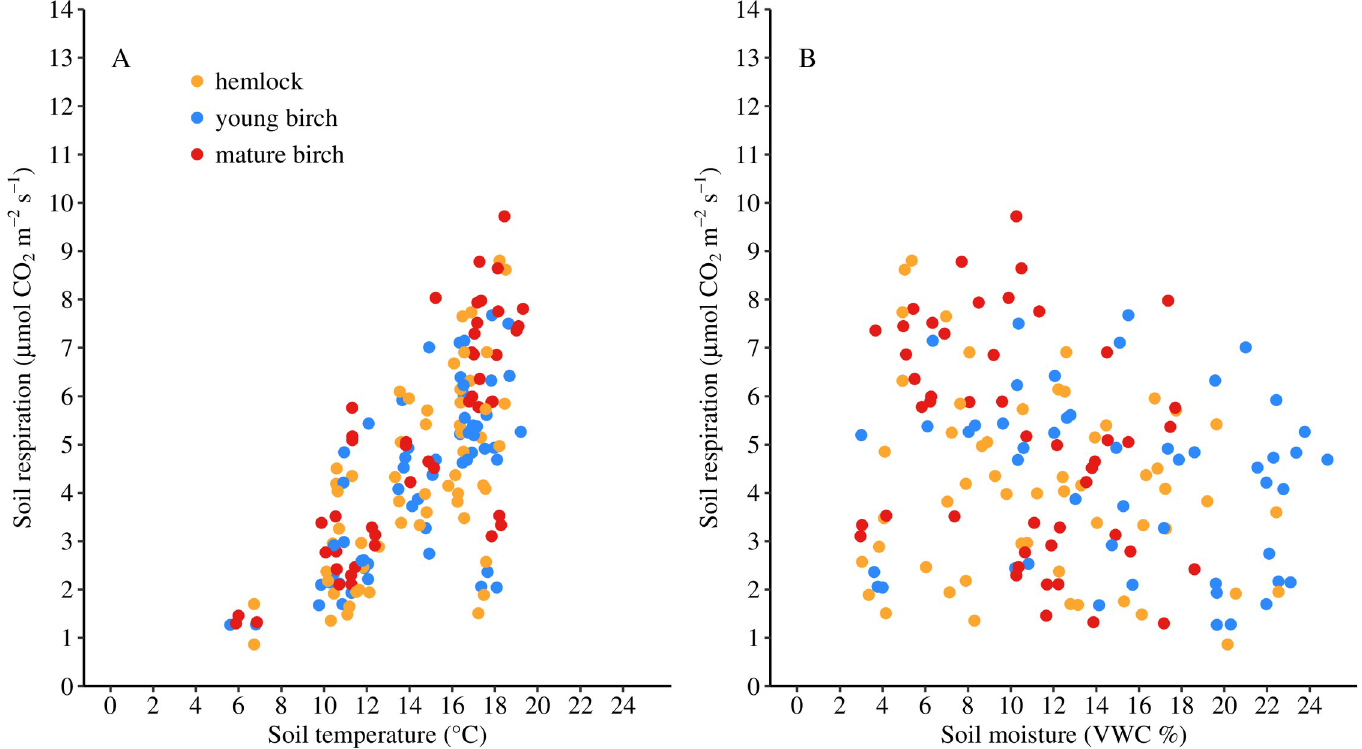
Fig 2. The relationship between soil respiration and the soil environment. The relationship between R s and (A) soil temperature (˚C) and (B) soil moisture (volumetric water content, VWC %) for each forest type from 2015–2017. All points are mean values per soil collar. The yellow, blue, and red points represent hemlock, young birch, and mature birch stands,